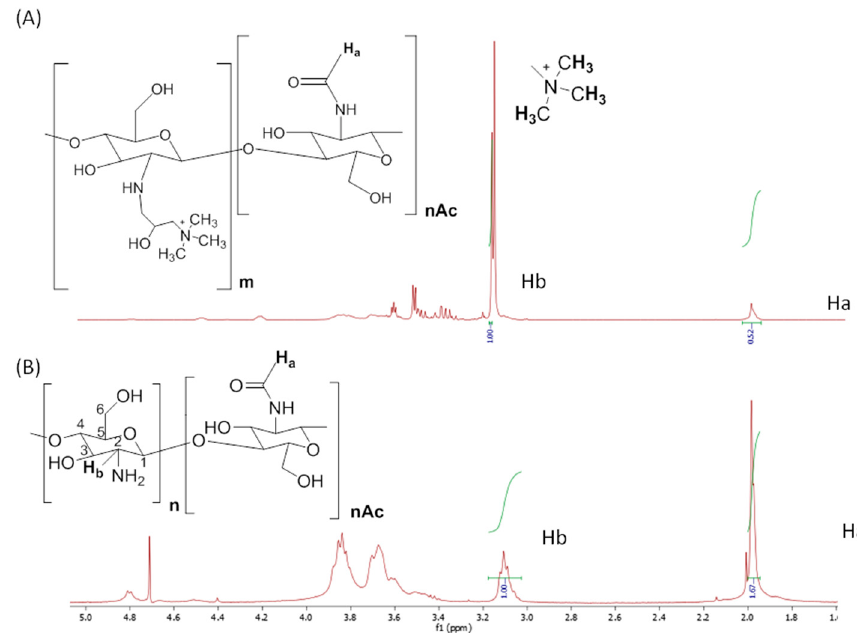
Figure 2. 1 H NMR spectrum of the ( A ) chitosan and ( B ) synthesized quaternized chitosan. The reaction of chitosans with ninhydrin is well-known as a rapid, sensitive, and reproducible method for the quantification of glucosamine (GlcNH 2 ) units [33,34]. Accord- ingly, the concentration of N-acetyl glucosamine residues on the prepared quaternized chitosan was measured by this colorimetric test (Abs = 8.4 × 106 C (mol/mL) R 2 = 0.9939) with the aim of quantifying the carried out chitosan functionalization reaction. The molar percentage of the remaining free amine moieties in the final chitosan was 3.2 ± 0.3, which led to a quaternization degree of 94%. 4.2. Synthesis of Chitosan/PEGBCOOH Nanogels The cross-linking of the different chitosans (low molecular weight chitosan, oligosac- charide chitosan, and quaternized chitosan) was carried out using diacid polyethylene glycol (PEGBCOOH) as a covalent cross-linker and the reverse microemulsion technique as a method of restricting the particle size at the nanoscale. According to the literature, the incorporation of PEGBCOOH seems to contribute to the water dispersibility at pH = 7.4 (physiological pH) of the cross-linked chitosan nanogels. Indeed, different works have already been devoted to the synthesis of chitosan covalent nanogels by the direct ami- dation reaction between the amino groups of chitosan and the carboxylic groups of differ- ent di- and triacids including succinic acid, tartaric acid, and PEGBCOOH, among others, showing high water dispersibility at pH 6.5 [35]. Pujana et al. [29] carried out this ami- dation reaction specifically with tartaric acid and PEGBCOOH within the microemulsion medium and they displayed an increasing water dispersibility at neutral-basic pH with the carboxylic acid content (soluble at pH = 8 for PEGBCOOH >37.5% mol). As described in the experimental section, the cross-linking of chitosan with the flexi- ble PEGBCOOH molecules requires the previous activation of their carboxylic groups, giving rise to the formation of intermediate N-hydroxysuccinimide esters (Figure 3). Sub- sequently, the cross-linking takes place by means of the nucleophilic attack of the free amine groups present in the different chitosans on the NHS-activated acid and with the formation of the consequent amide bond.